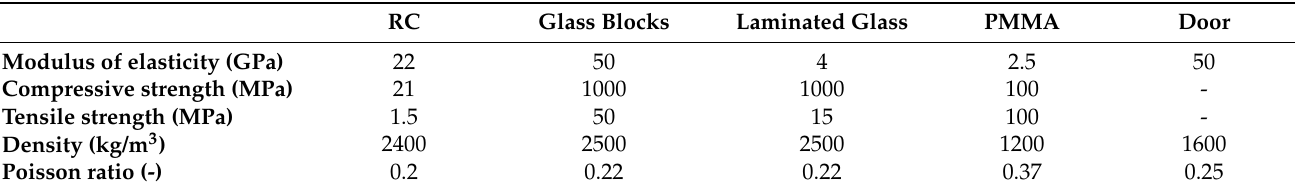
Table 2. Adopted material